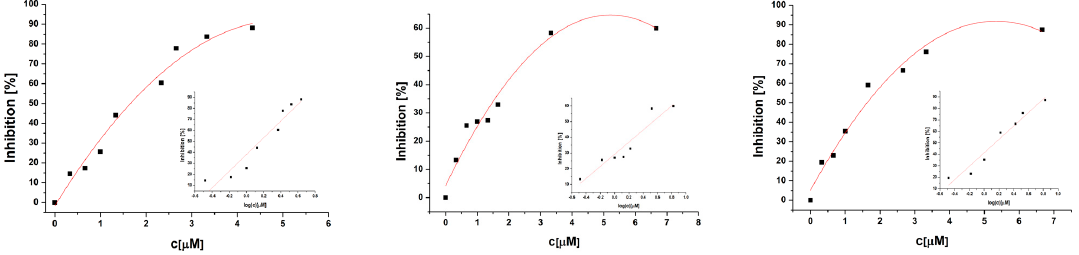
Figure 6. SOD mimetic activity of 2 , 3 and 4